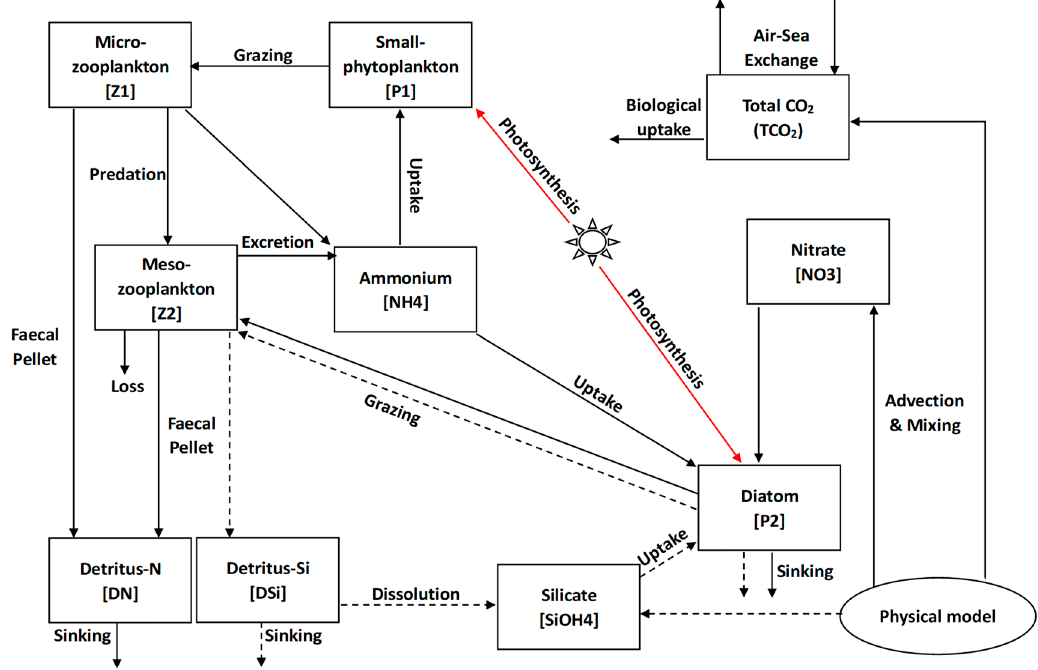
Figure 2. Flowchart of the CoSiNE model in the euphotic layer. Solid lines represent the flow of nitrogen, while dashed lines represent the flow of silicon.